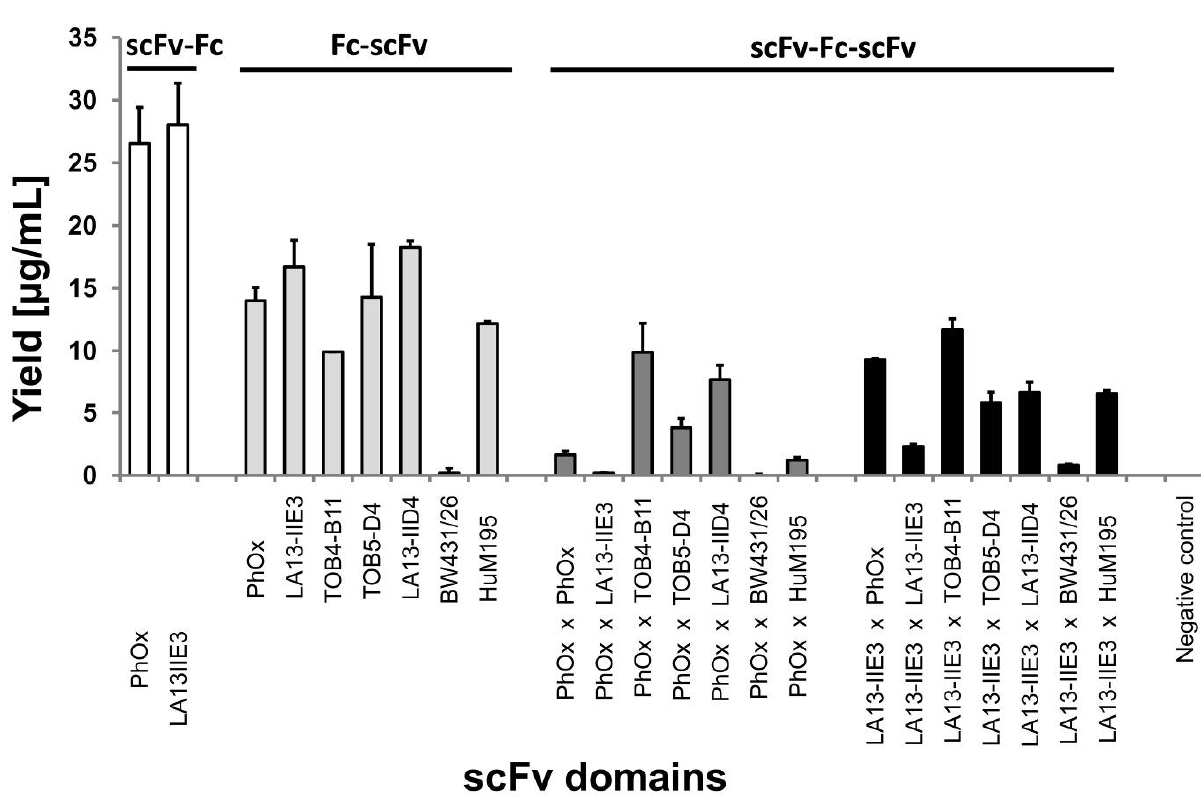
Figure 2. Volumetric yields of transient production of scFv-Fc, Fc-scFv and scFv-Fc-scFv antibodies in HEK293T cells. Production supernatants were analyzed by human IgG/Fc capture enzyme immunosorbent assay